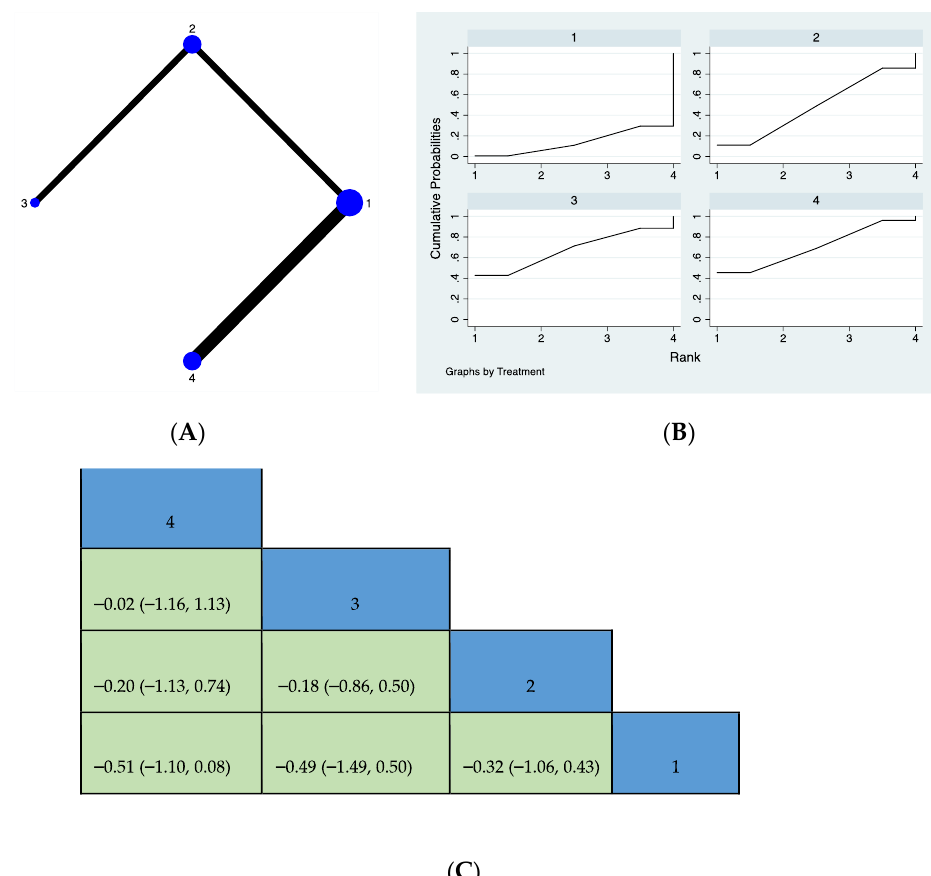
Figure 4. ( A ) NMA figure for 10 m sprint, ( B ) SUCRA plot for 10 m sprint; ( C ) league table of 10 m sprints. 1 = control group; 2 = resistance training group; 3 = plyometric training group; 4 = plyometric + resistance + sprint + agility training group.